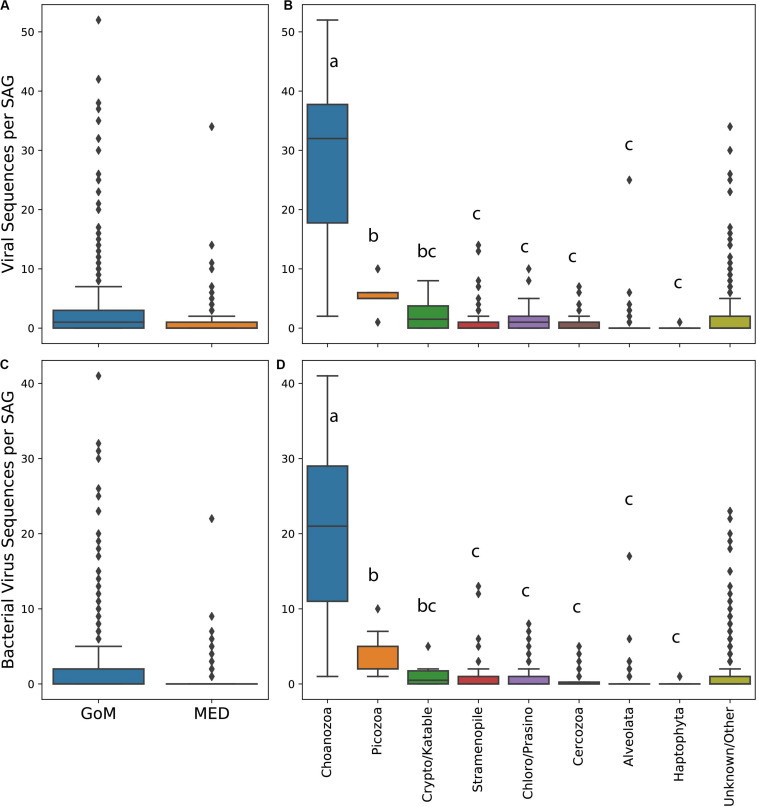
Box and whisker plots of abundance of viral sequences in SAGs from the Mediterranean and Gulf of Maine (A), abundance of viral sequences in different protist taxa (B), abundance of bacterial virus sequences in SAGs from the Mediterranean and Gulf of Maine (C), and abundance of bacterial virus sequences in SAGs from different protist taxa (D). Lowercase letters in plots (B) and (D) indicate results of a post hoc Tukey test.